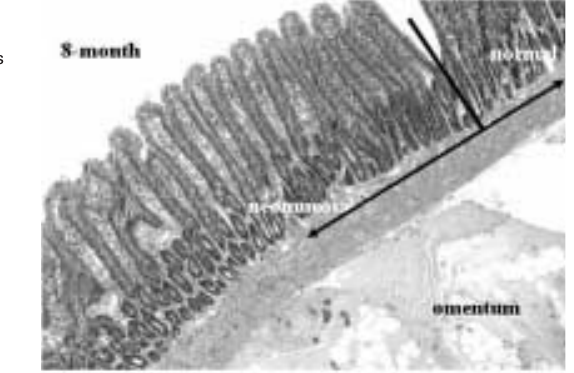
Figure 7 Eight month speci- men. Neomucosa has well-developed regular villi and ma- ture crypts, and is similar to the normal small bowel mucosa.